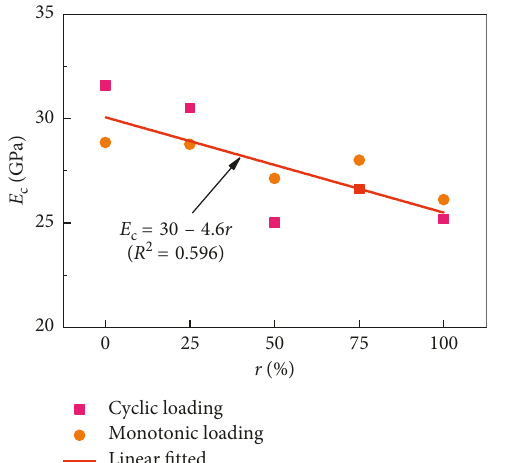
Figure 7: Effect of the RCA replacement percentage on the elastic